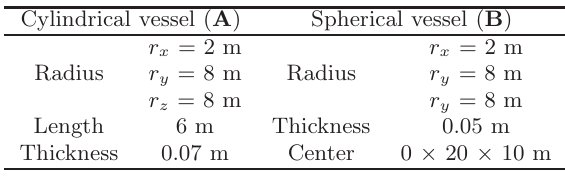
Table 1. Data for the numerical simulations.